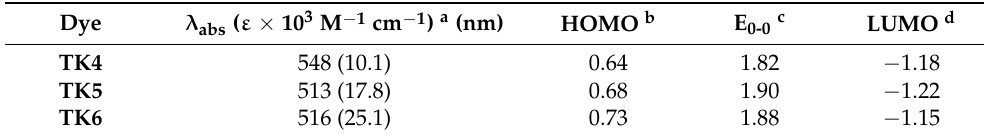
Table 7. Absorption and electrochemical data of TK4 , TK5 and TK6 . Dye λ abs ( ε × 10 3 M − 1 cm − 1 ) a (nm)